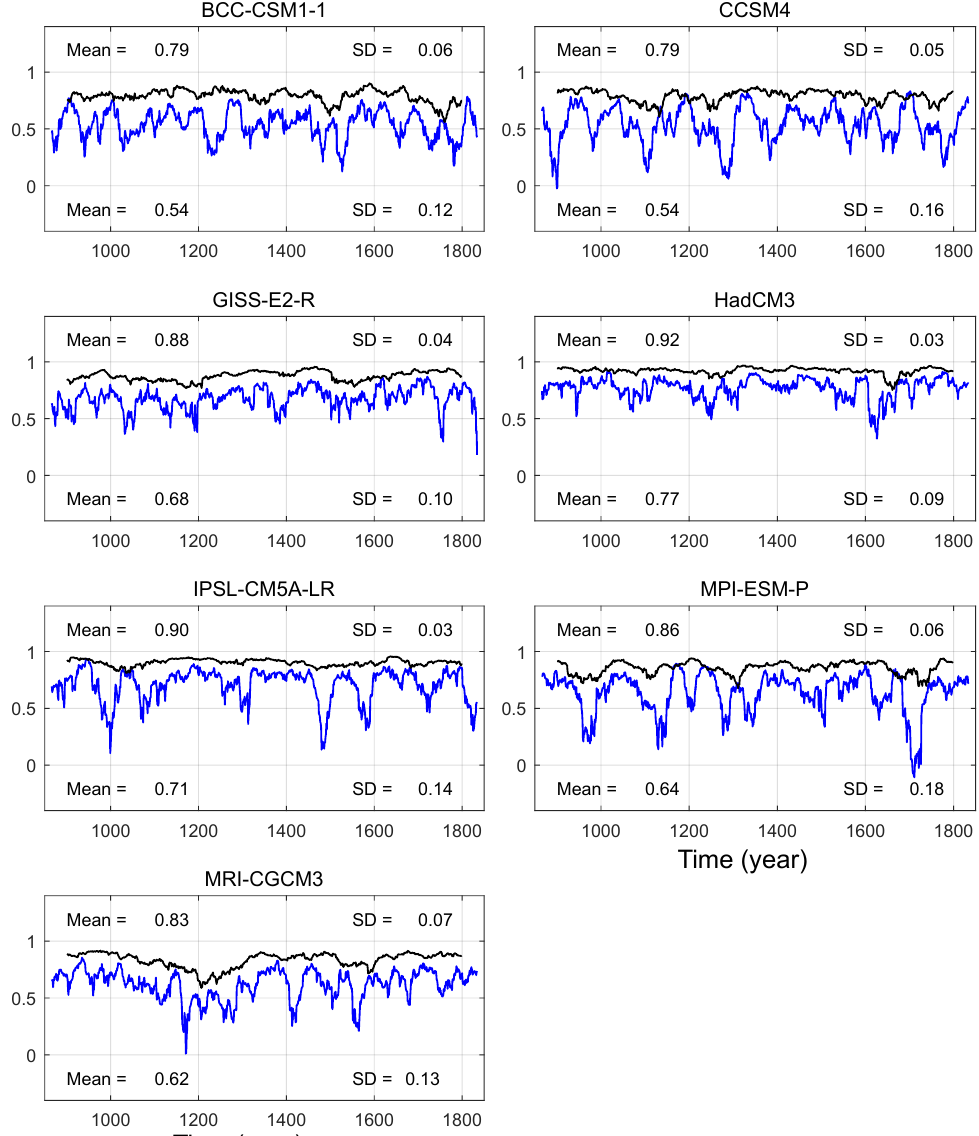
Figure 5. RPCs of the EASM strength and summer precipitation over East Asia (10–50 ◦ N, 100–130 ◦ E) in the PMIP3 models. Blue (black) lines represent 31-year (101-year) RPCs, with averages and standard deviations shown below